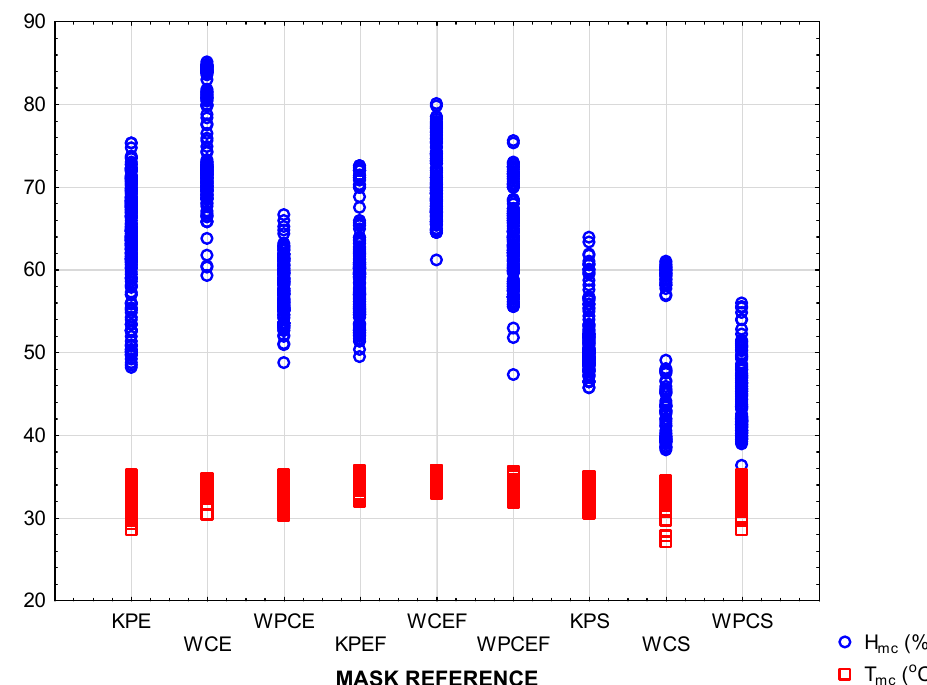
Figure 4. Scatterplot of multiple variates to provide an overview of all the data, depicted per mask design.